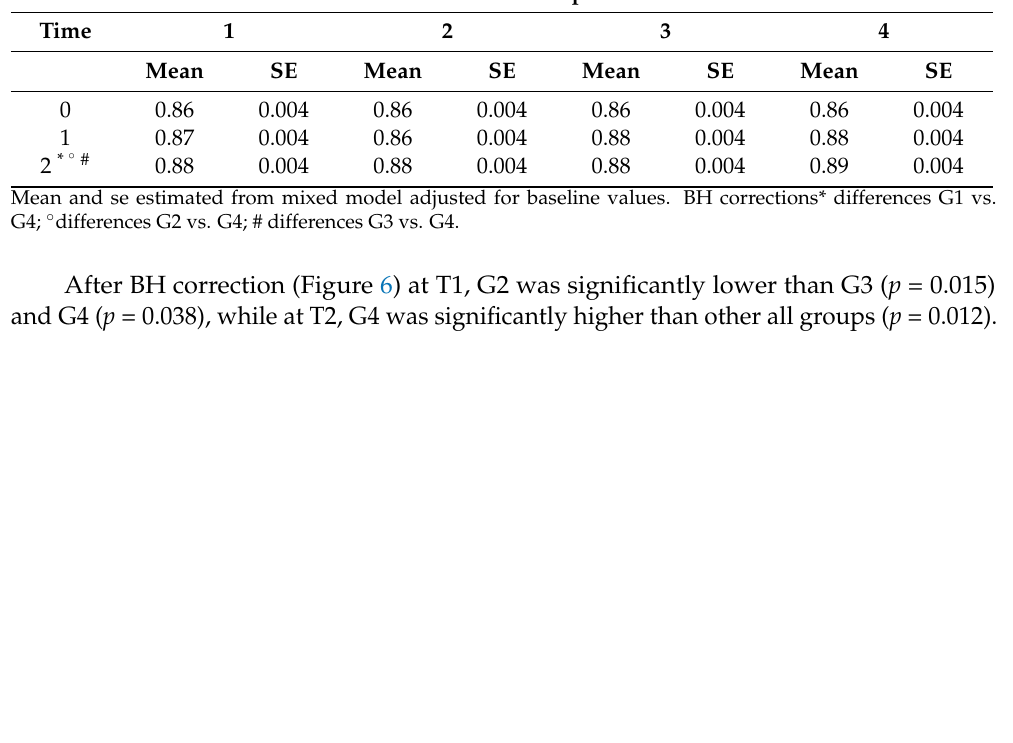
Table 4. Estimated mean from mixed model corrected by baseline values.